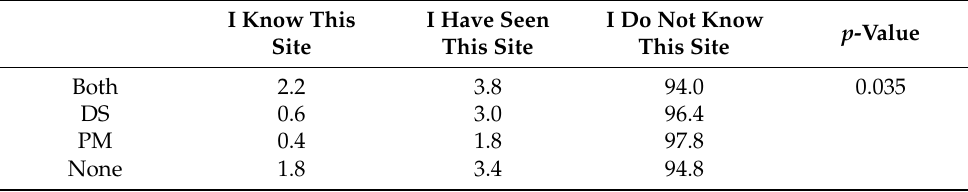
Table 9. Awareness of the Health Food Network consumer navigation site.